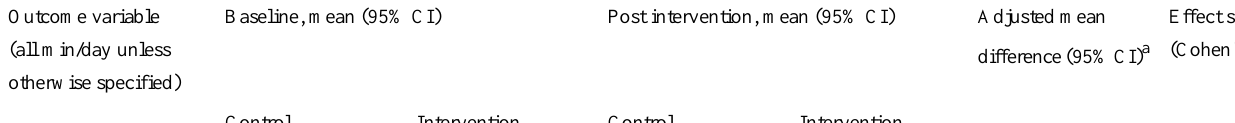
Table 2. Baseline and postintervention values, adjusted differences, and effect sizes for sedentary behavior